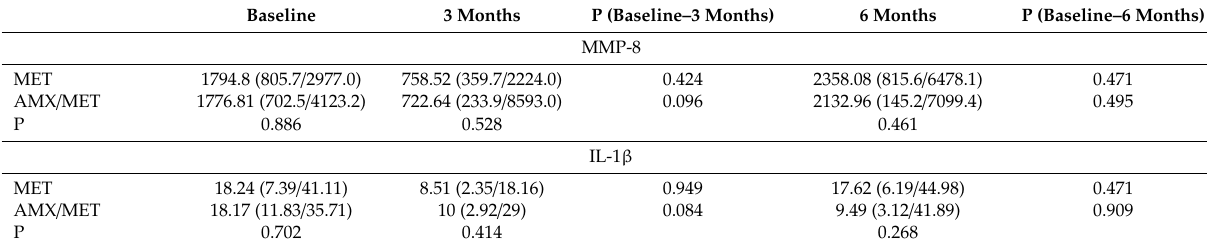
Table 4. Biomarker levels (pg / sample; median (25 percentile / 75 percentile) at baseline, after three and six months in the MET (subgingival instrumentation + metronidazole) and the AMX / MET groups (subgingival instrumentation + metronidazole /